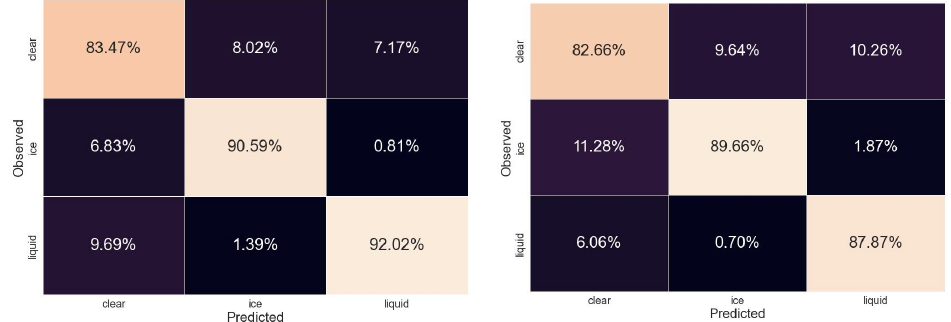
Figure 7. As in Figure 6 but using AMSU-A/MHS synthetic dataset.